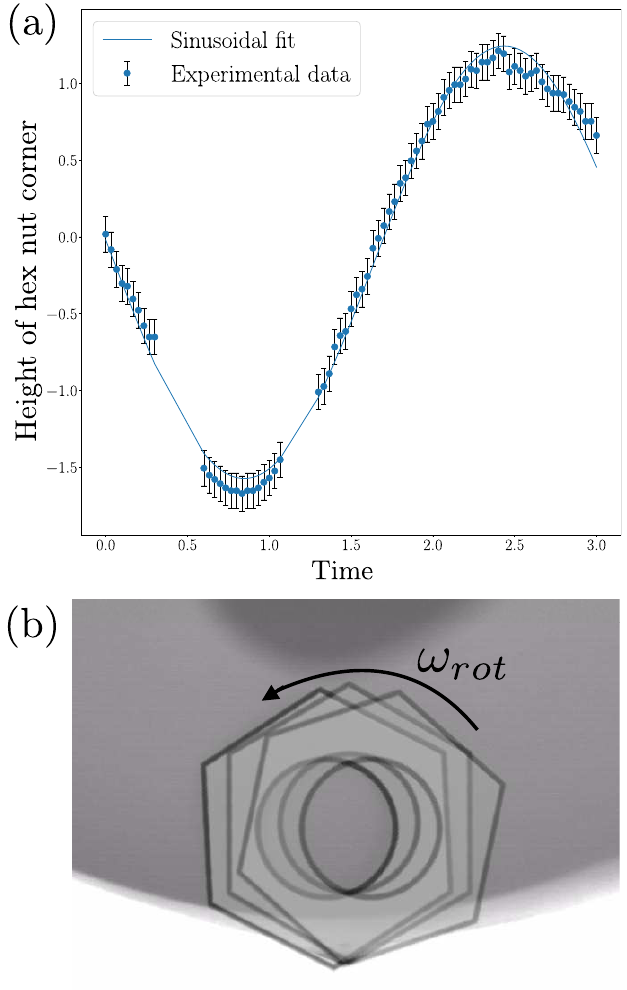
Fig. 4. (a) Experimental data of the height of a corner of the nut during one rotation of the nut extracted using Tracker (soft- ware). A sinusoidal fit is performed on the experimental data and plotted in solid line. (b) Superposition of three images of the nut rolling on the membrane taken with a high-speed camera at 3000 fps. For visualisation purposes the hex nut is